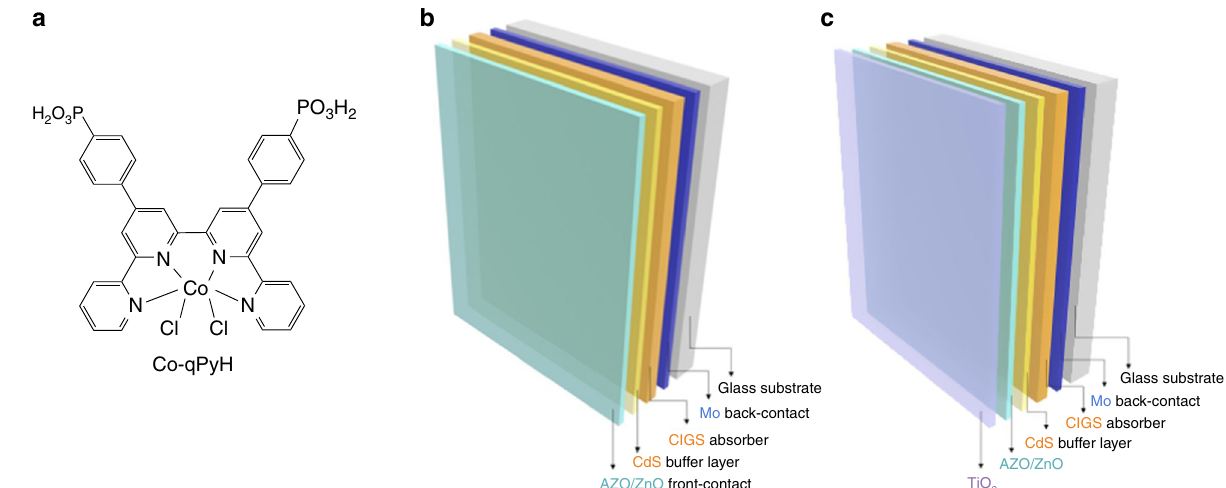
Fig. 1 Electrode components. Structure of the Co-qPyH molecular catalyst bearing phosphonic acid functions ( a ). Schematic view of the CIGS-based layered material used in PV conditions ( b ) and in PEC conditions ( c ). Additional layers to CIGS are molybdenum (Mo), cadmium sul fi de (CdS), aluminum- doped zinc oxide (AZO/ZnO), and titanium dioxide (TiO 2 ).